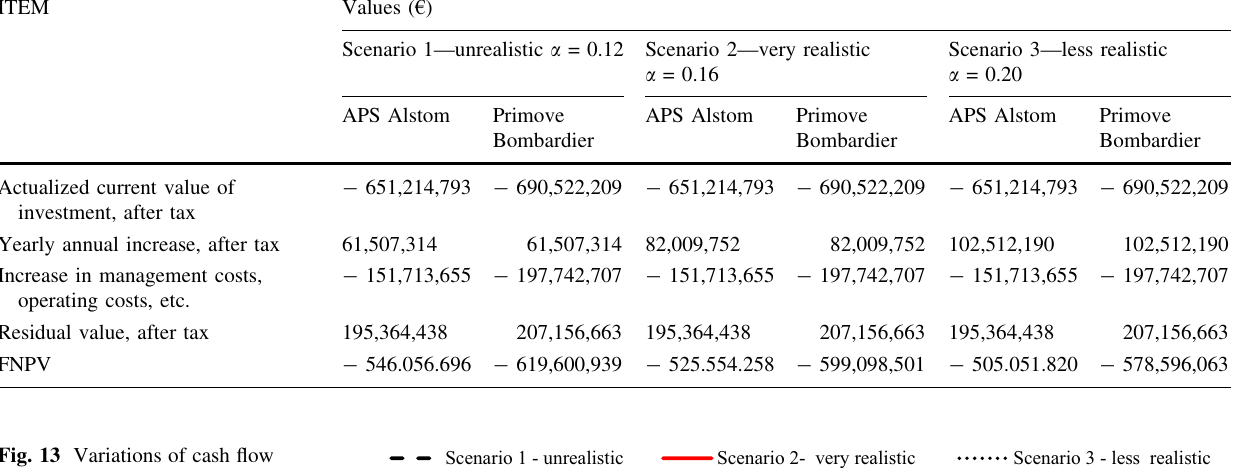
Table 11 Scenario TP 2 (realization of lines A ? B ? C ? D ? E ? F ? G)